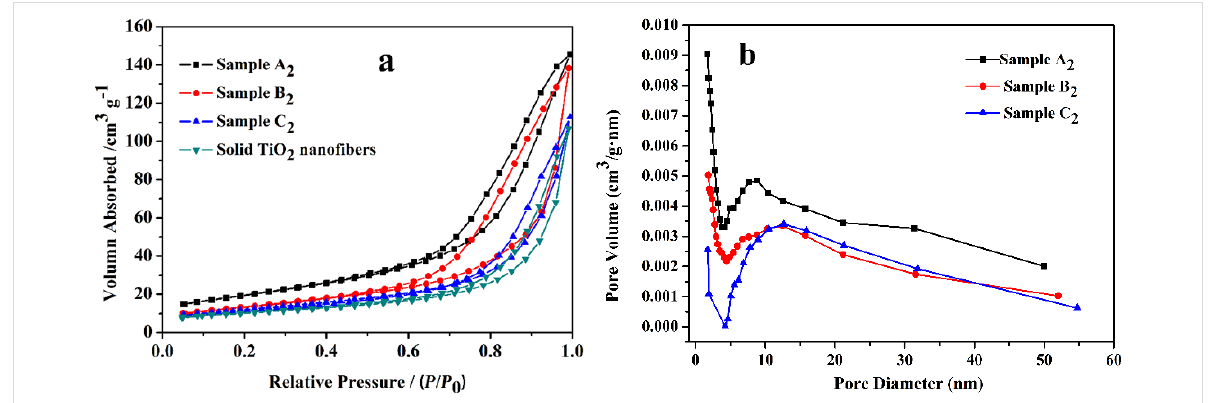
Figure 5: (a) Nitrogen adsorption–desorption curves of sample A 2 , sample B 2 , sample C 2 and solid TiO 2 nanofibers; (b) pore-size distribution of sam- ple A 2 , sample B 2 , sample C 2 .